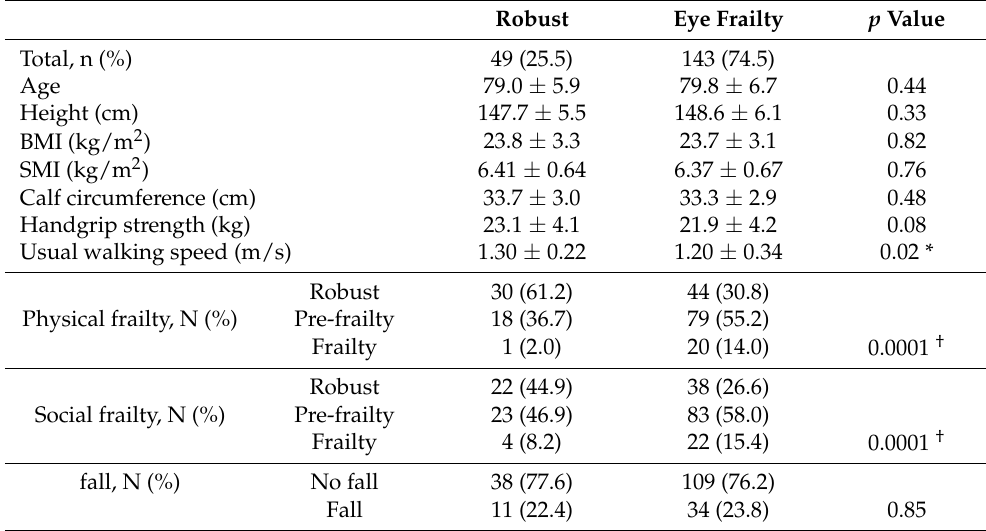
Table 3. Demographic data according to healthy and eye frailty groups.